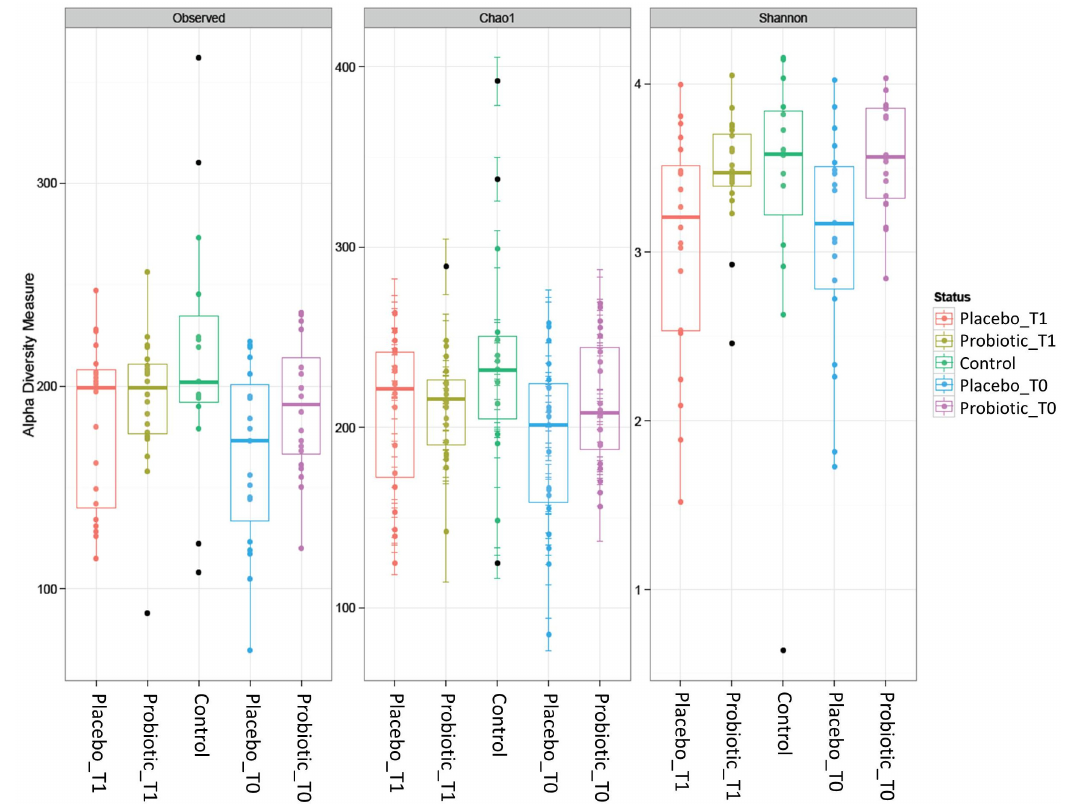
Figure 7. Alpha diversity indices among the studied groups.